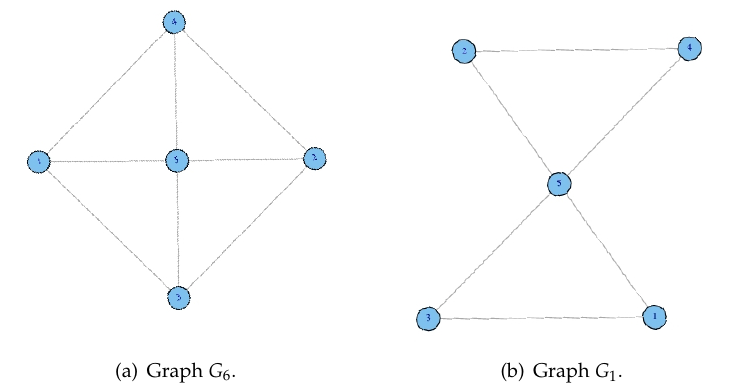
Figure 7. Two networks G 6 and G 1 representing different styles.